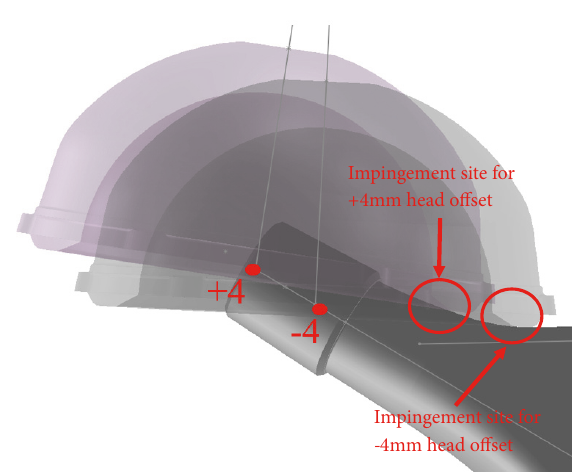
Figure 4: 40mm polyethylene liner engaging at -4mm head offset compares to engaging at +4mm offset.